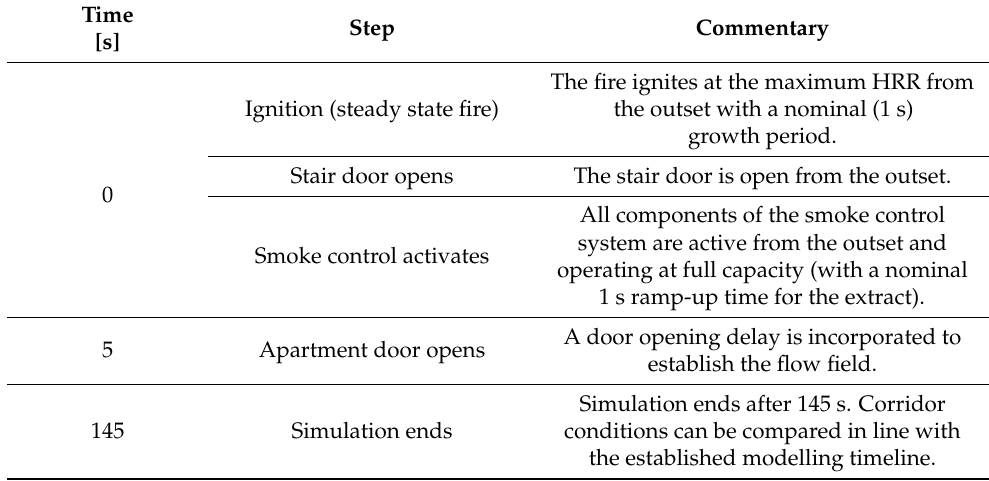
Table 7. Compressed firefighting